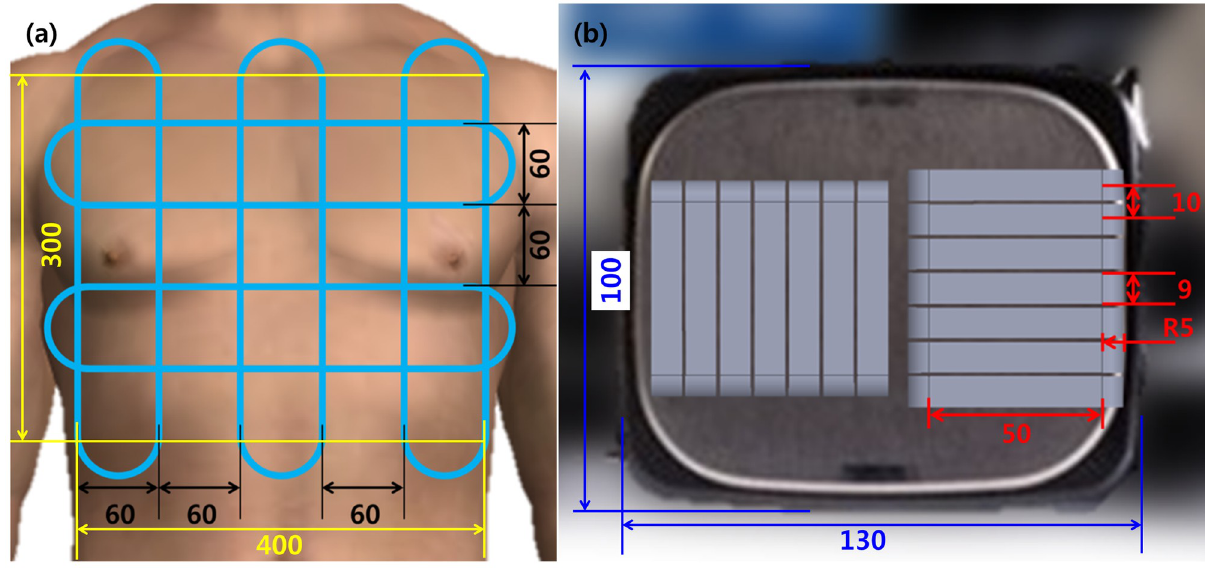
Fig 2. Size and coils placement of chest manikin and defibrillator positioning paddle. (a) chest manikin; (b) paddle.